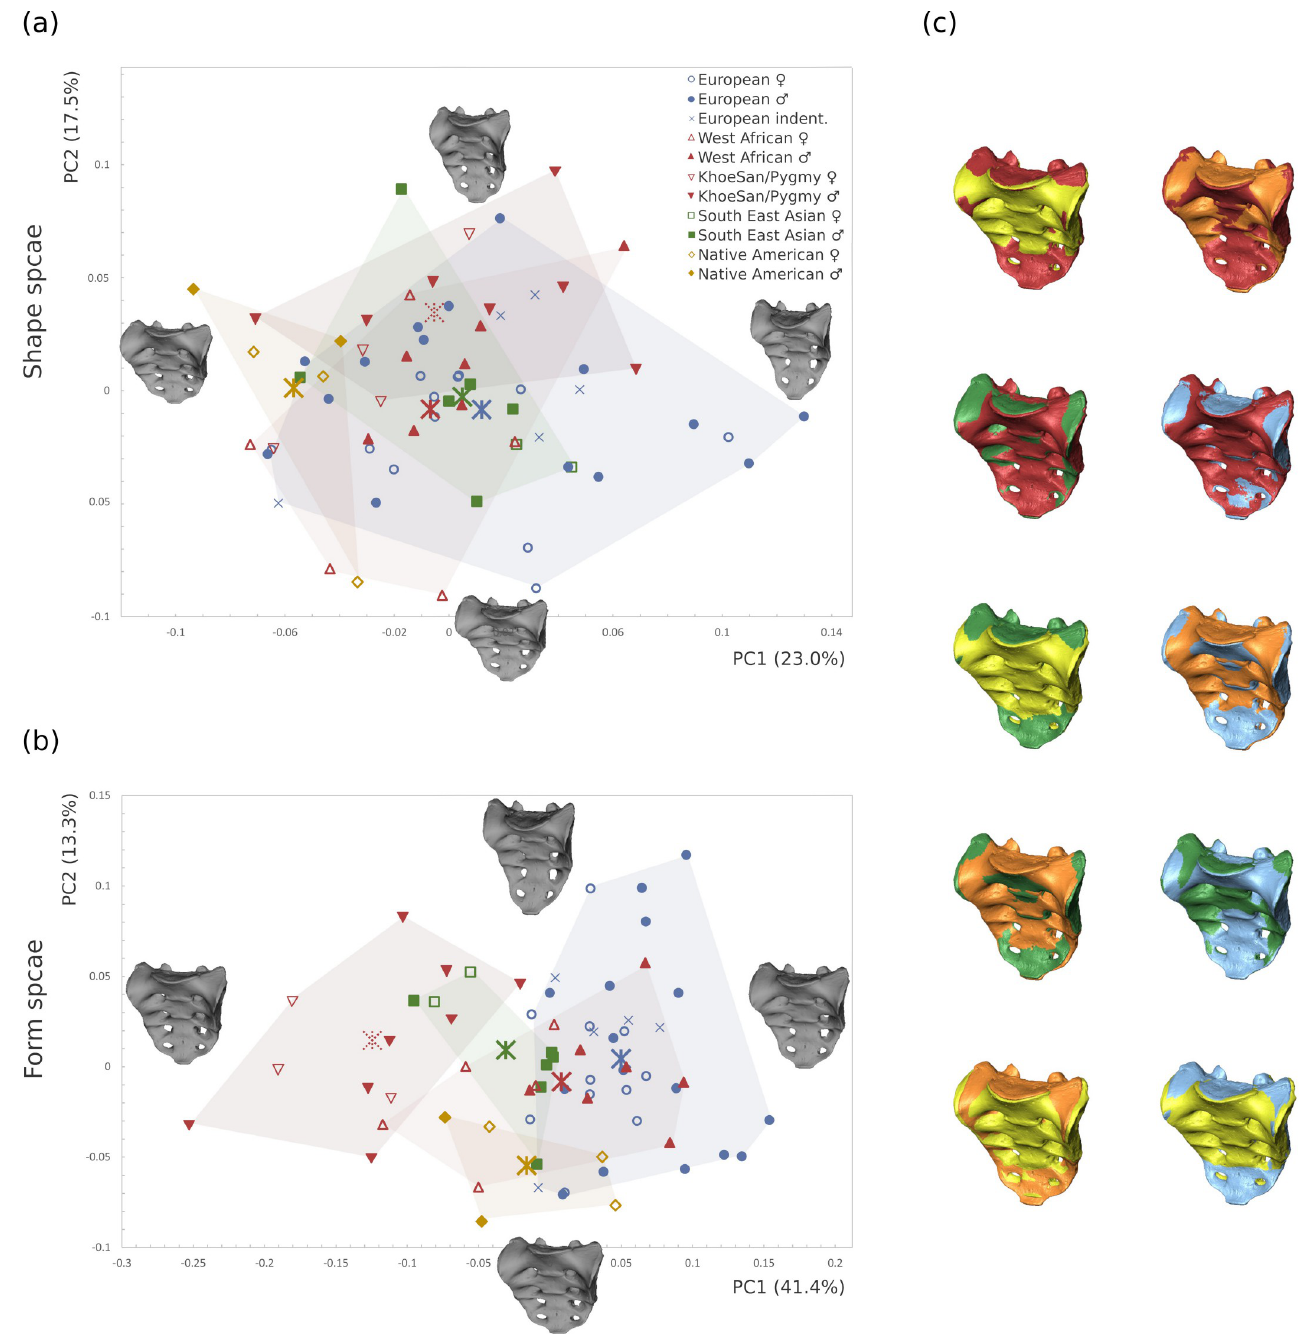
Fig 3. PCA plot of the sample without central europeans (n = 68). The Central European specimens from the Weisbach collection were excluded to avoid overrepresentation of the European subgroup. The thin-plate-spline warps show the shapes at the extremes of the axes in (a) shape space (b) form space. (c) Pairwise comparisons between the mean shapes of the different subgroups (Europeans = blue, West Africans = red, Khoesan and Pygmies = orange, South East Asians = green, Native Americans =